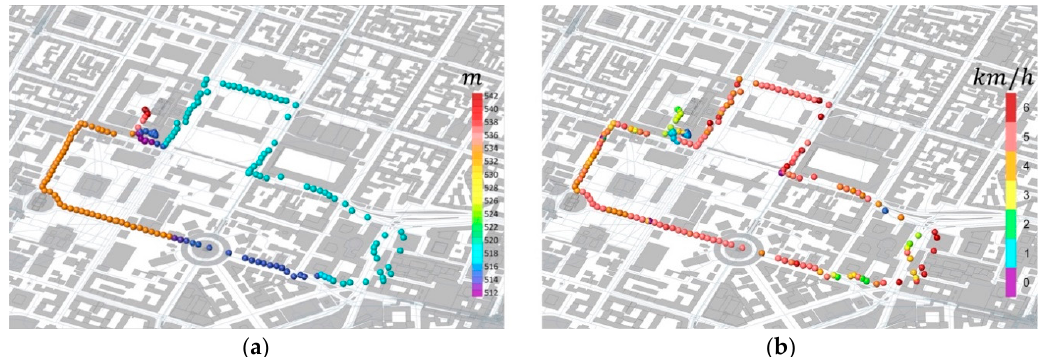
Figure 25. ( a ) Elevation of the path (m); ( b ) walking ground speed (km/h).